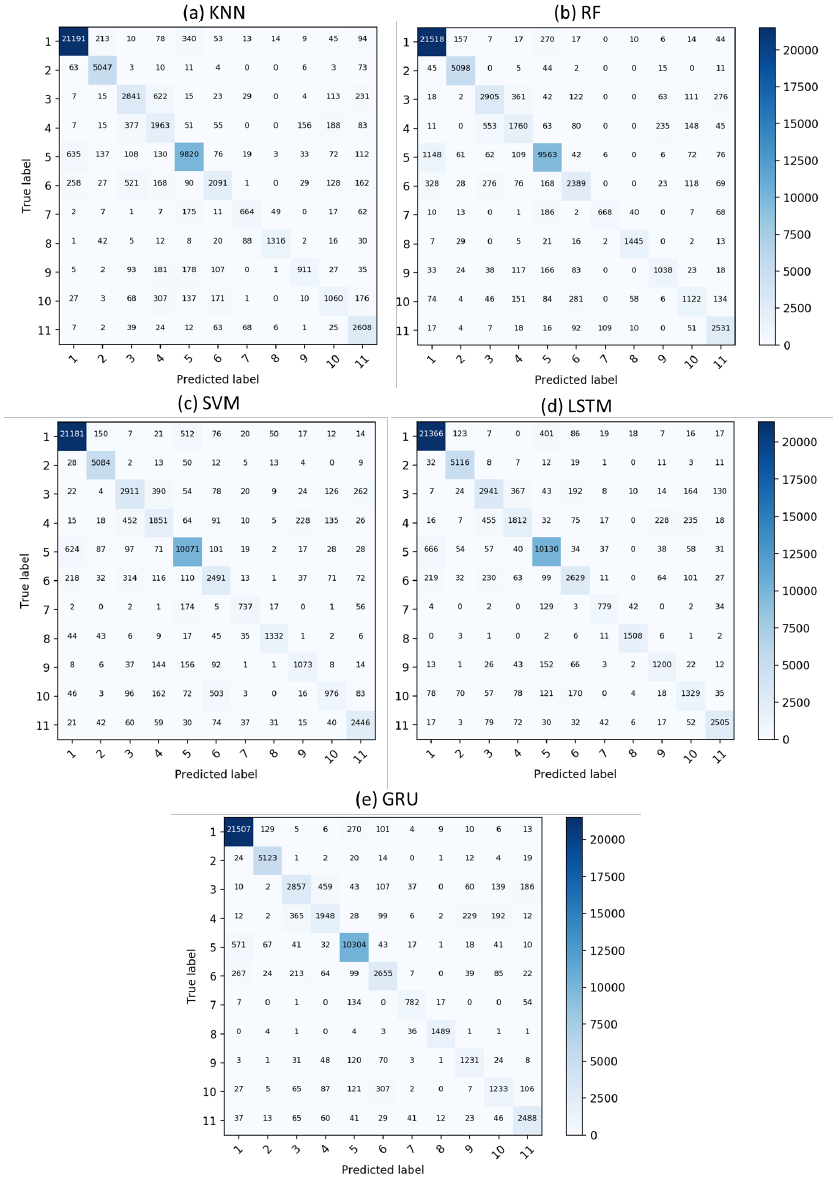
Figure 6. Per Class F-Measure of the different approaches.